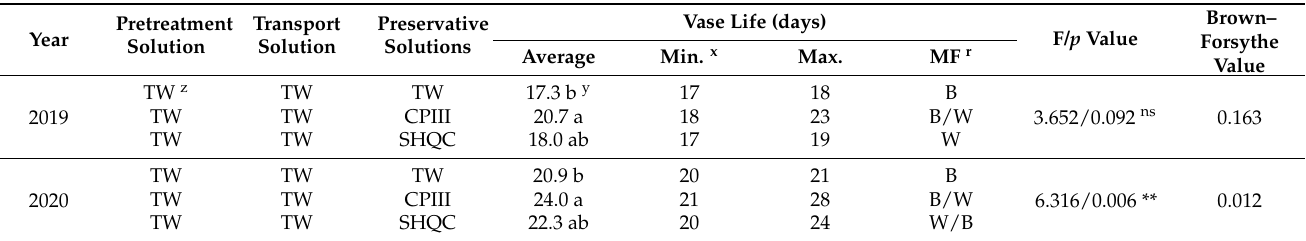
Table 2. Vase life and main factor of senescence of cut hydrangea flowers ‘Verena’ kept in each preservative solution treatment in 2019 and